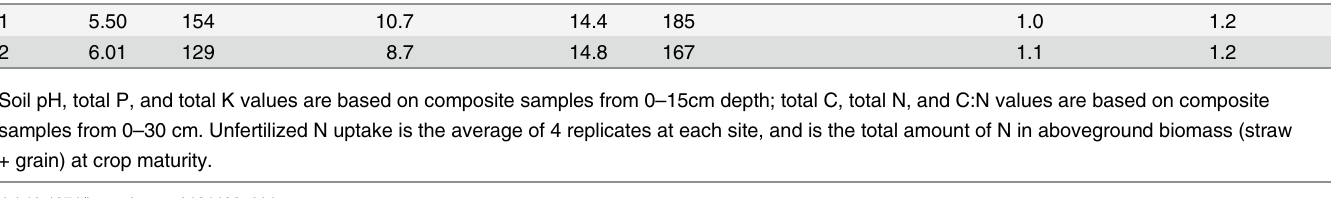
Table 1. Summary of soil characteristics for Twitchell Island rice fields.